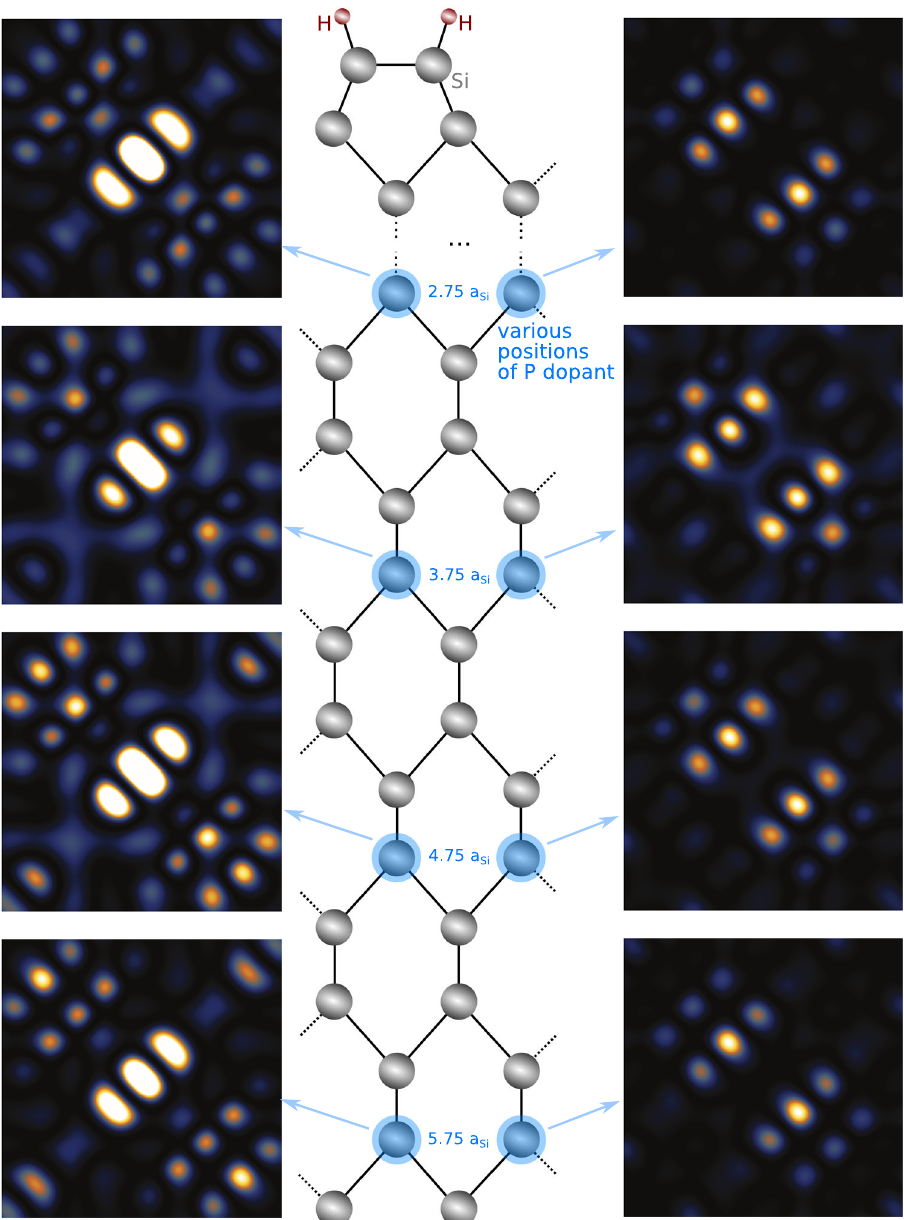
Fig. 5 Simulated STM images for various dopant locations. All images use the same general tip state. Each image is independently normalized to highlight changes in the relative intensities of the features in each image instead of the overall depth-dependent intensity